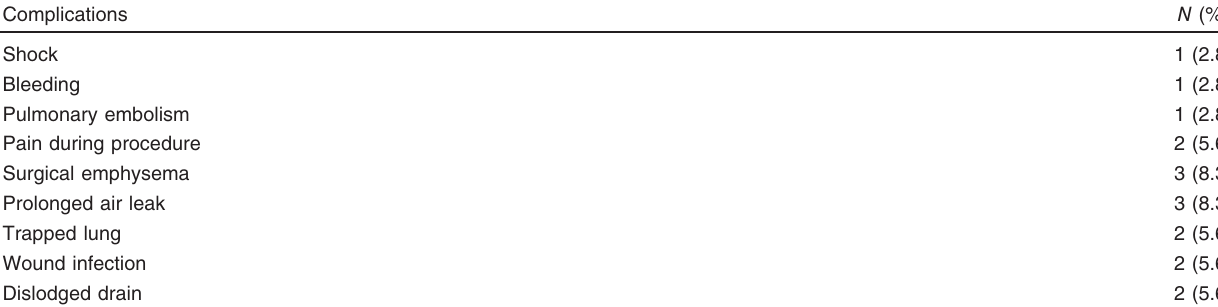
Table 8 Different complications of medical thoracoscopy among studied patients